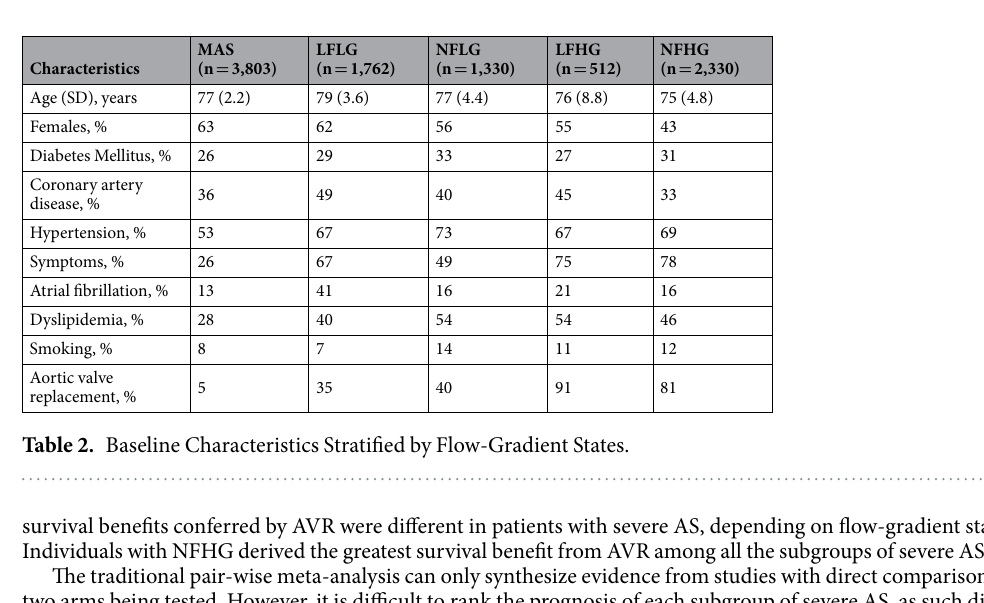
Table 1. Study characteristics. MAS: moderate aortic stenosis; LFLG: low-flow low-gradient; NFLG: normal- flow low-gradient; IFLG: indeterminate-flow low-gradient; LFHG: low-flow high-gradient; NFHG: normal-flow high-gradient; IFHG: indeterminate-flow high-gradient; CAD: coronary artery disease; HTN: hypertension; SYM: symptoms present; AVR: aortic valve replacement.